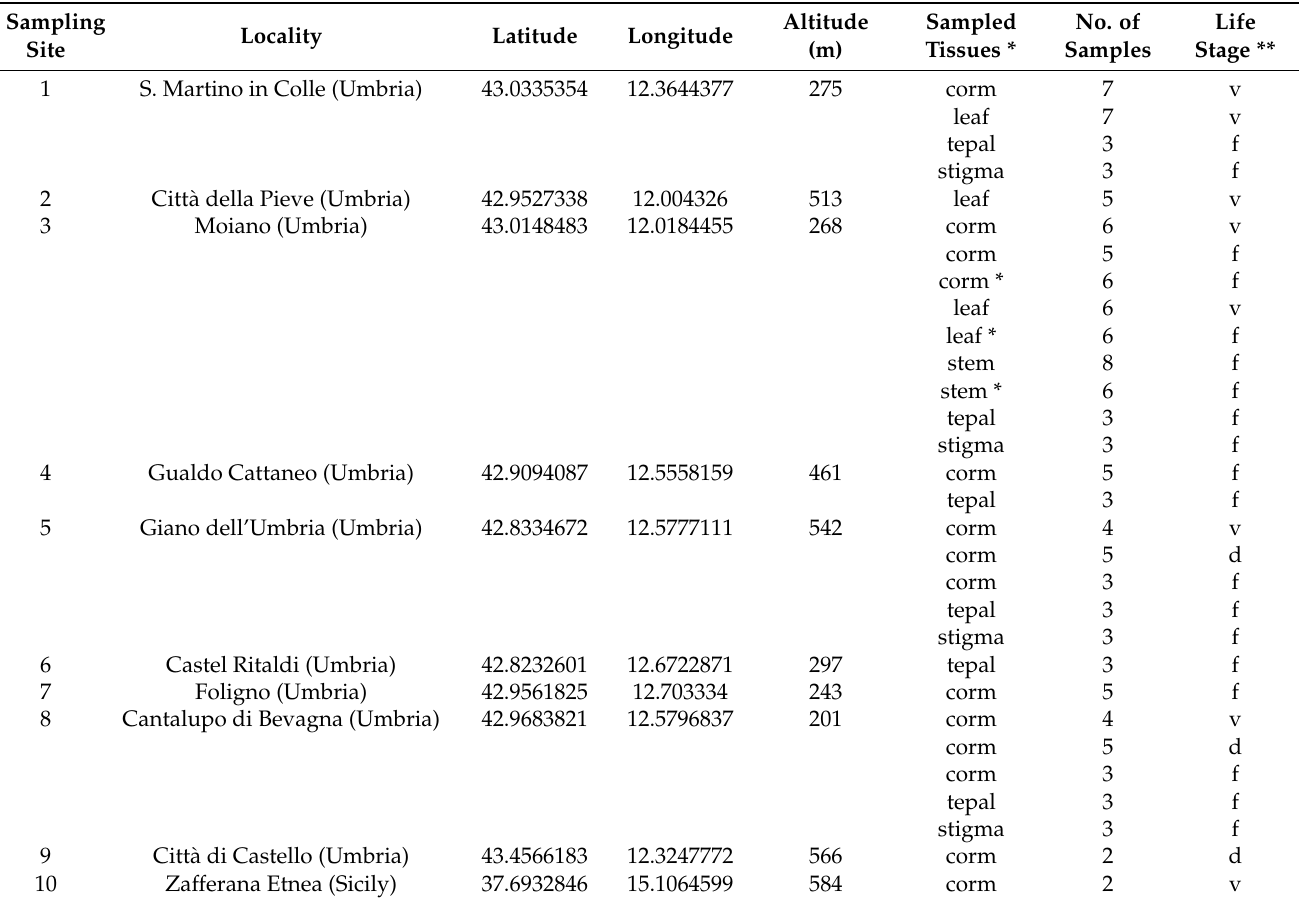
Table 1. Sampling sites, life stages, and health state of the examined saffron tissues. * Samples collected from rotten plants; ** life stages: v= vegetative, f = flowering, d =